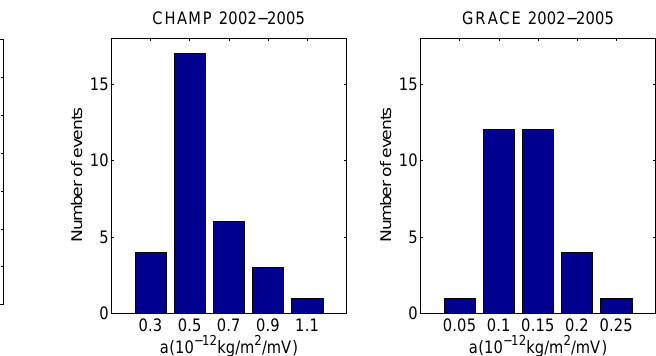
Fig. 2. The delayed orbit-averaged mass density response with re- spect to E m for CHAMP (left) and GRACE (right). The y-axis indicates the number of storm events per bin.